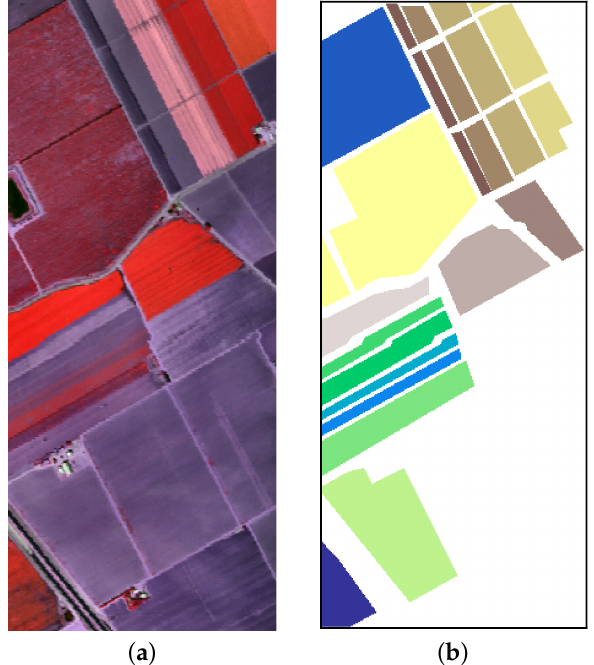
Figure 10. SV dataset. ( a ) False-color image. ( b ) Ground truth.